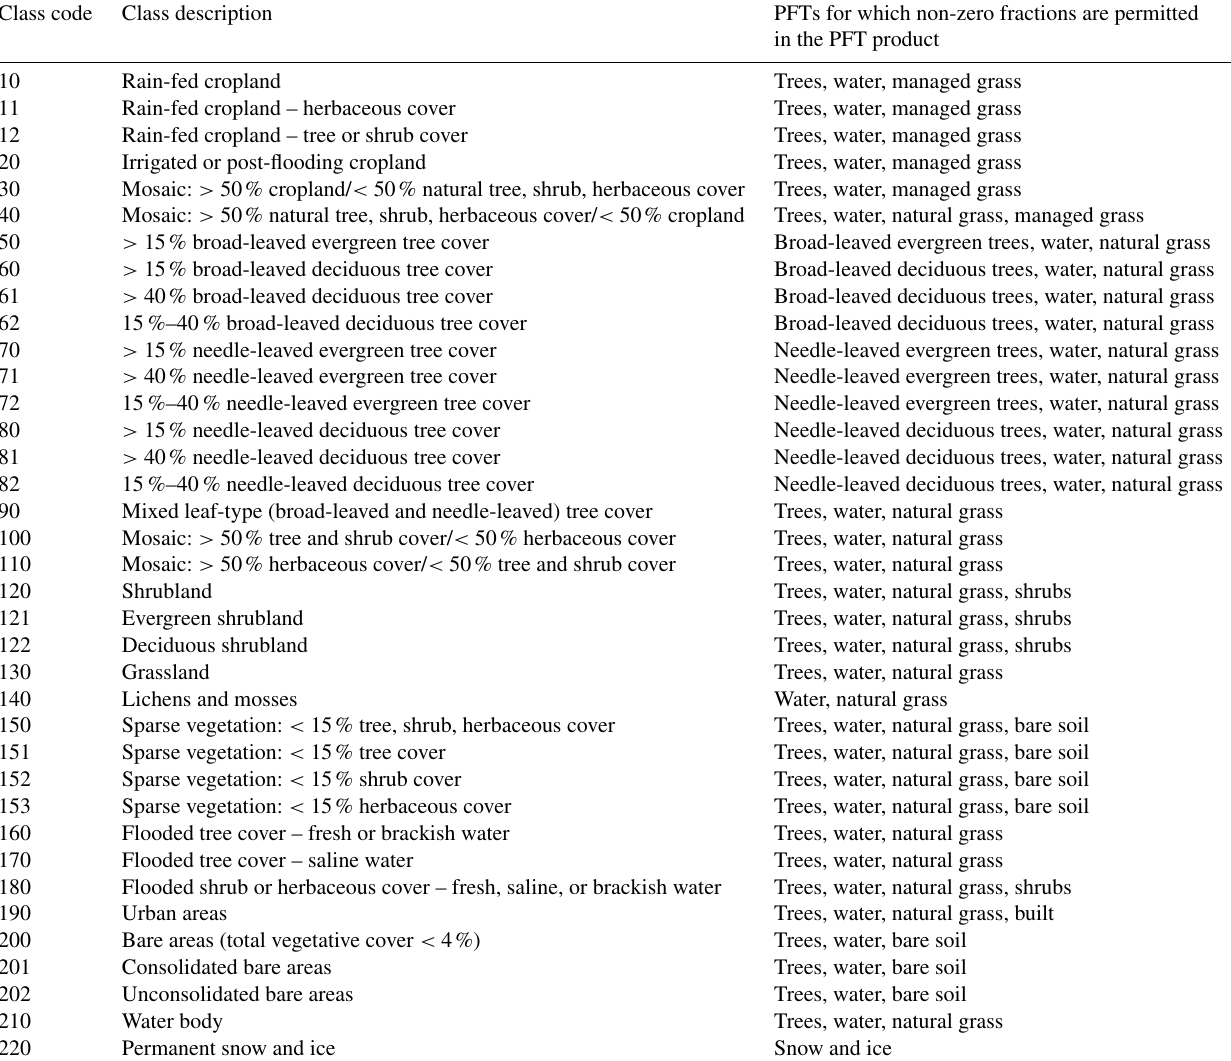
Table 1. For each of the 22 global and 15 regional land cover classes of the CCI MRLC map series, listed is the set of contributing PFTs with the possibility of non-zero fractional cover. The regional land cover classes with codes ending in 1, 2, or 3 are thematically richer than the global classes but can be found only at the regional scale depending on training data